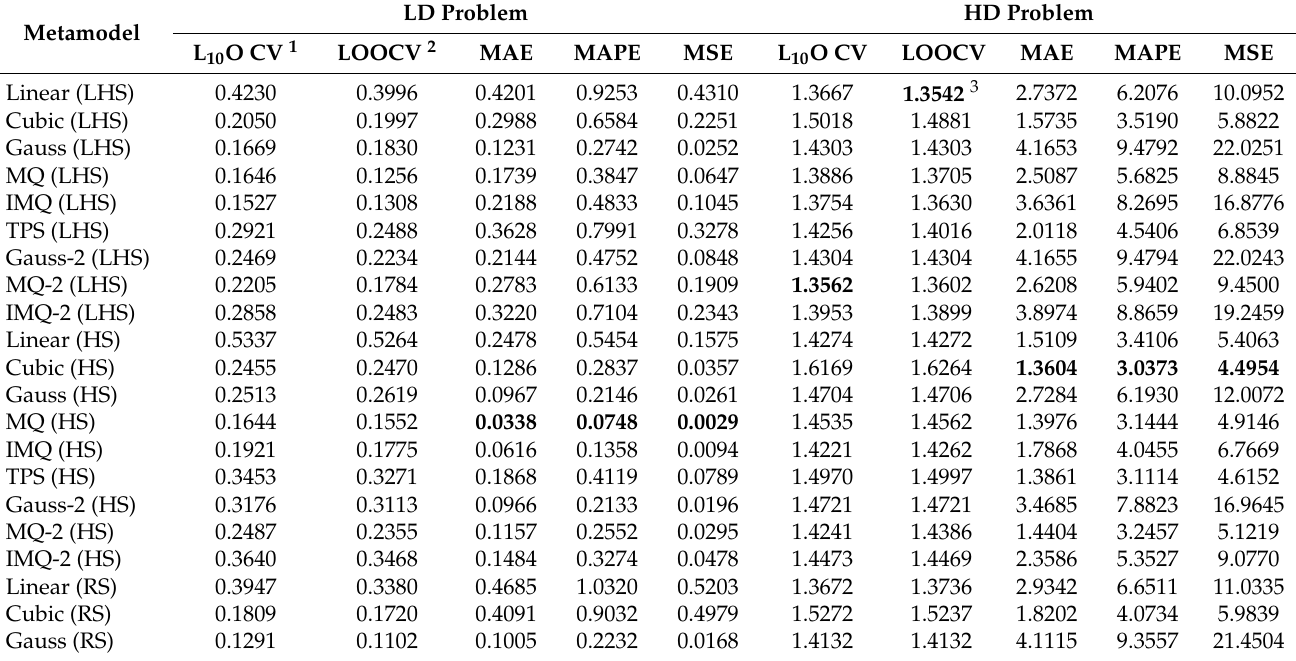
Table A1. Comparison of all metamodels based on various metrics for first